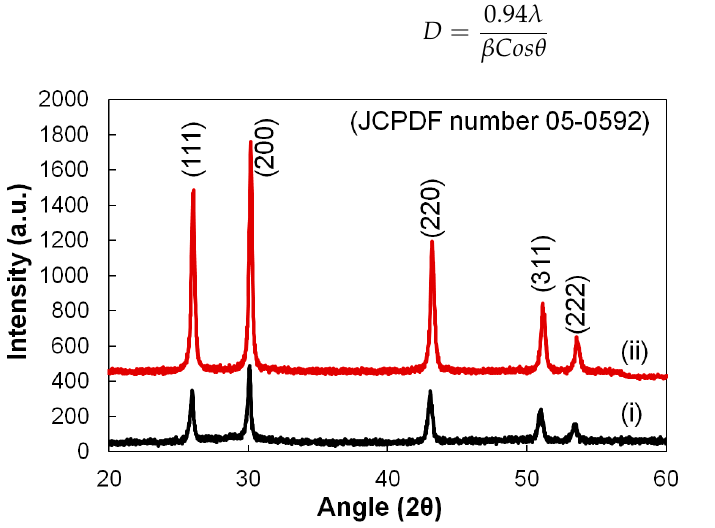
Figure 2. XRD pattern of PbS nanoparticles synthesized via plant-extract supported method, (i) for 300 °C and (ii) is for 360 °C of calcination temperature.